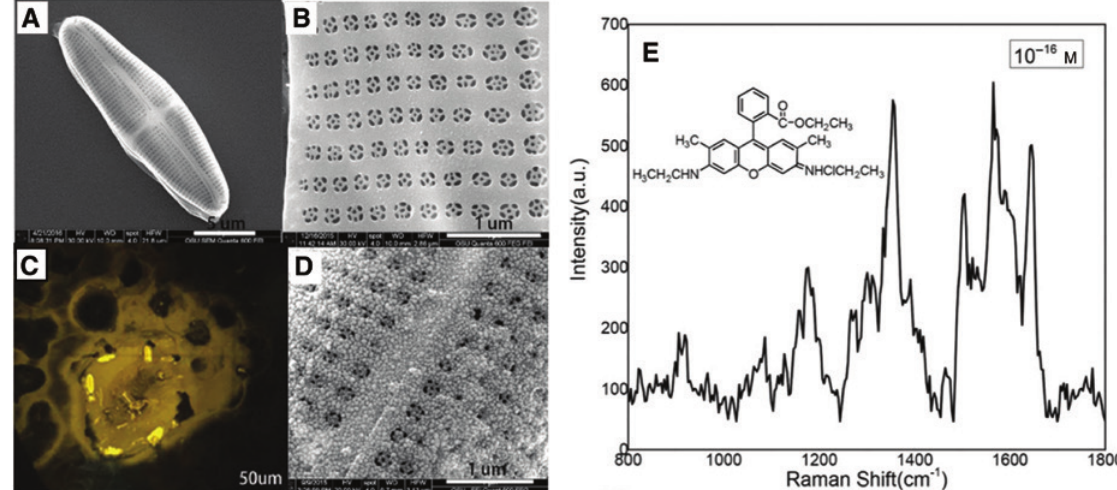
Figure 33: A single-molecule biosensor comprising self-assembled silver nanoparticles on photonic-crystal-like diatom biosilica. (A), (B), and (D) SEM visualisation of (A) a single diatom frustule ( Pinnularia ) harbouring (B) arrays of pores and (D) silver seeds deposited onto it. (C) 200 fluorescent droplets (20 nl) of aqueous R6G solution (10 −7 m) displayed on the device, as well as (E) the SERS spectrum of 2000 droplets at 10 − 16 m exhibiting extraordinary sensitivity. Adapted from [180].